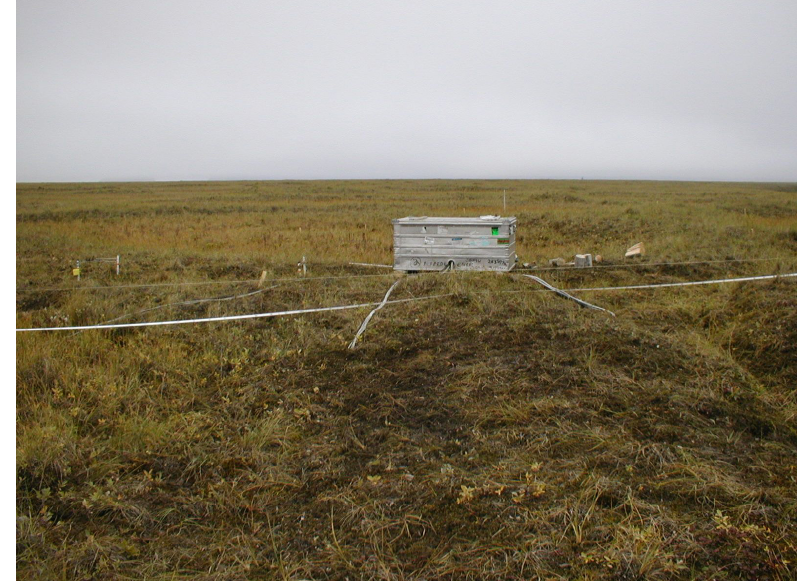
Figure B10. Research site after instrument installation in soil pits and subsequent refilling, August 2002. Cable strings indicate locations of centre, slope, and rim profiles.